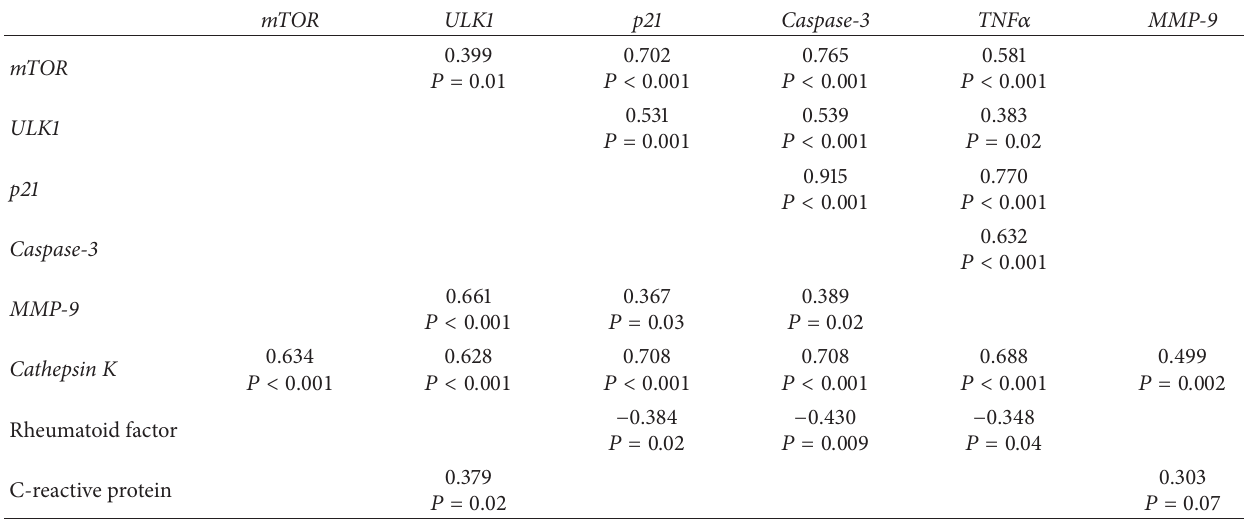
Table 1: Correlation coefficients (Spearman’s) and their significance ( 𝑃 ) are shown for the expression of the examined genes in relation to each other and the disease markers in a sample of RA patients ( 𝑛 = 33